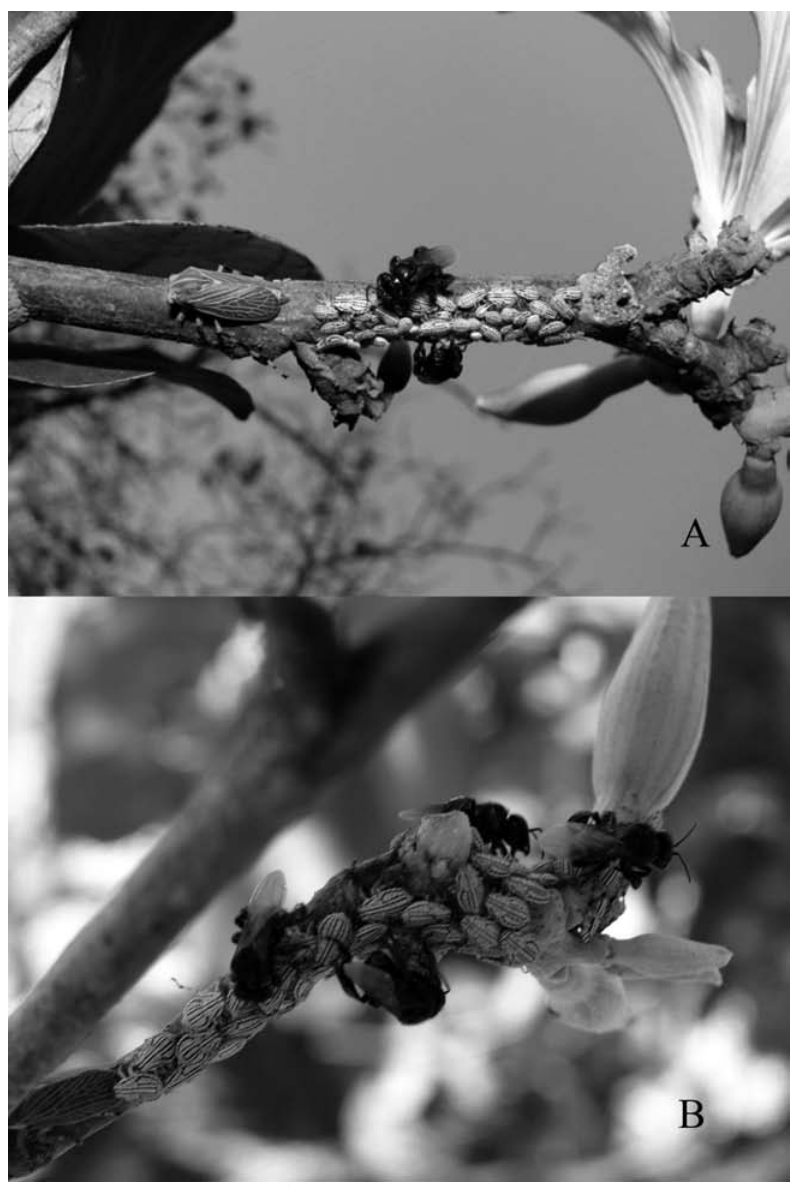
Fig. 1. Antennal stimulation by T. branneri on the distal part of A. reticulatum nymphs' abdomen, next to a flower of B. forficata in Parque Nacional das Emas, Goiás, Brazil (A). Note the number of Trigona bees on the colony of A. reticulatum